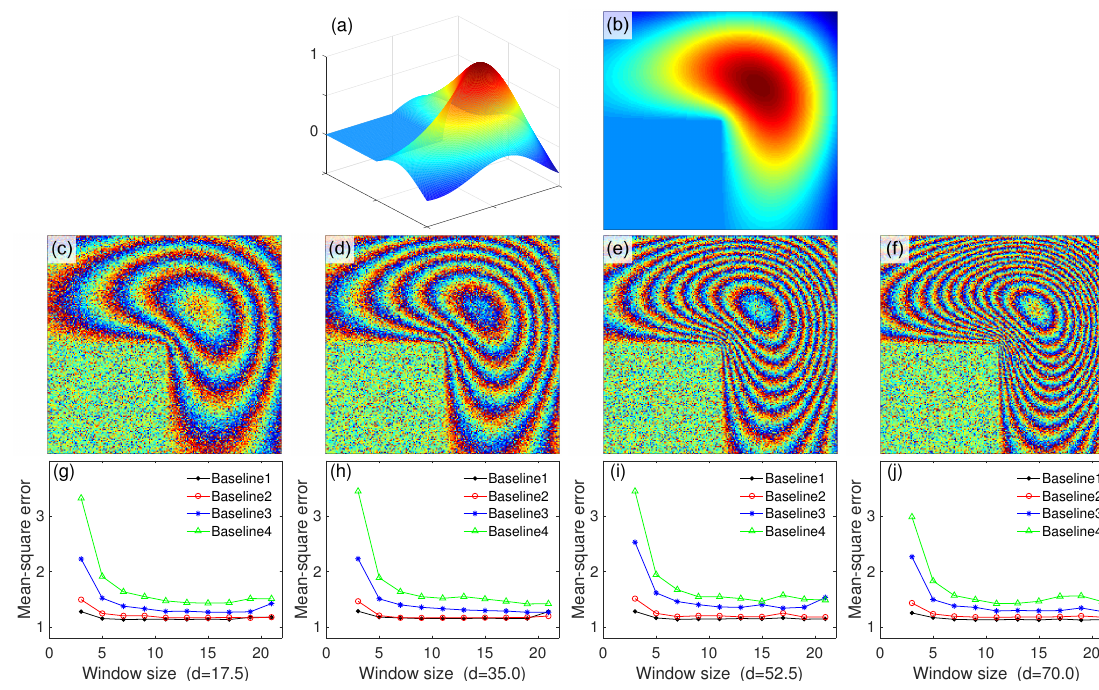
Figure 9. ( a , b ) The examples of simulated terrain in 3D space and reference unwrapped phase in 2D space. ( c – f ) The examples of simulated wrapped phases with baseline lengths 2 m, 3 m, 5 m, and 7 m ( d = 70, coherence coefficient is 0.75). ( g – j ) MSE curves with different values of d s. Table 7. Statistical Information of PU Performance in Figure 9g–j. Means of the MSE Curves Variances of the MSE